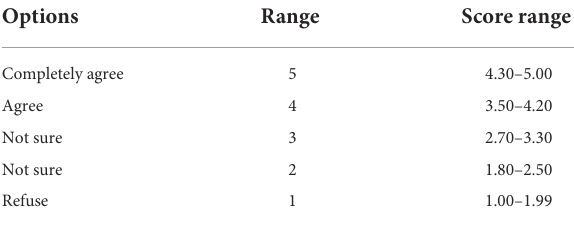
TABLE 4 Scale options and score